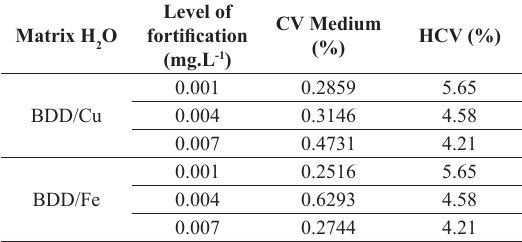
Table 4. Coefficients of variation of the means of the SWASV peaks obtained and the coefficient of variation of